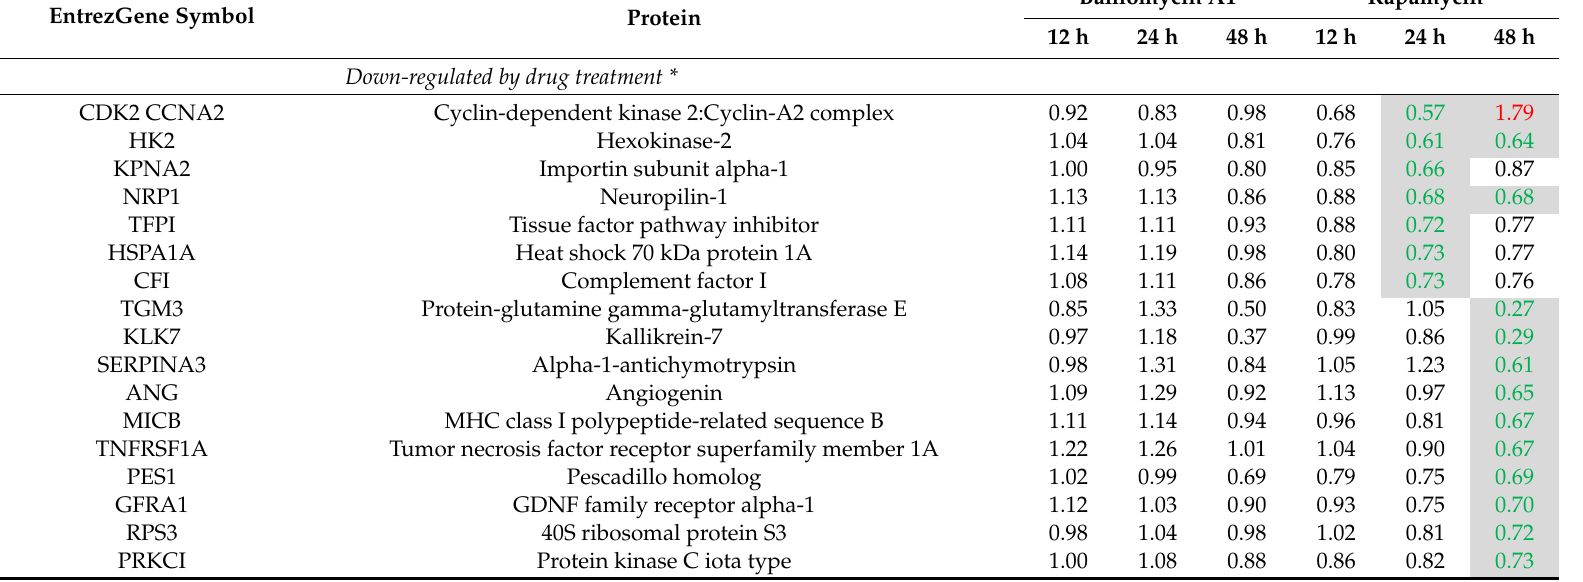
sorted by down-regulation from left to